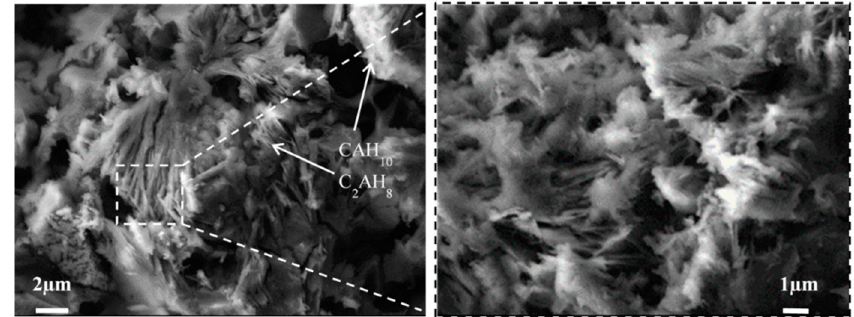
Figure 5. The microstructure images of control specimen G0 after 3 days of hardening.